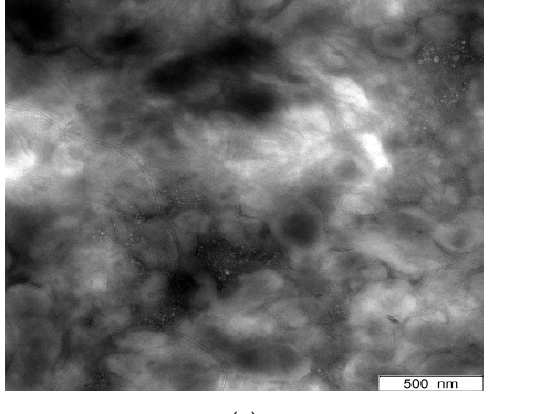
( a ) Figure 7. Composites with CNTs pretreated with surfactants, ( a ) dielectric conductivity and ( b ) stress–strain analyses. Stress–strain analyses likewise indicate a decrease in reinforcement implying dete- rioration in dispersion. Elongation at break values rise while the elastic modulus de- creases at low strain. Surfactant and solvent residues account for the softening behavior,